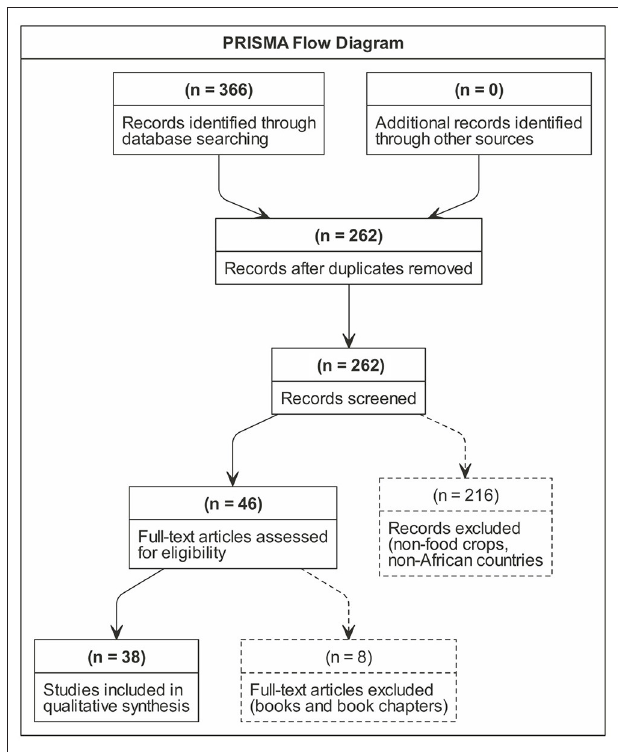
FIGURE 1 | PRISMA flow